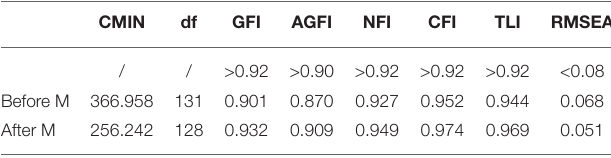
TABLE 6 | Fit statistics of hypothetical model 2 of